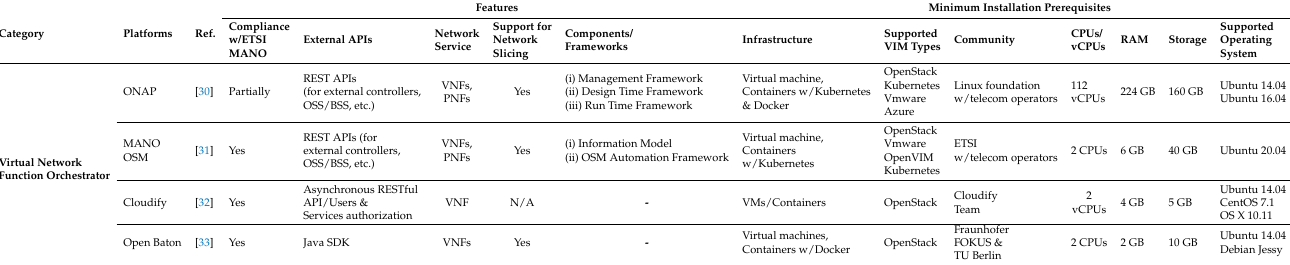
Table 3. Comparison of NFV Orchestration